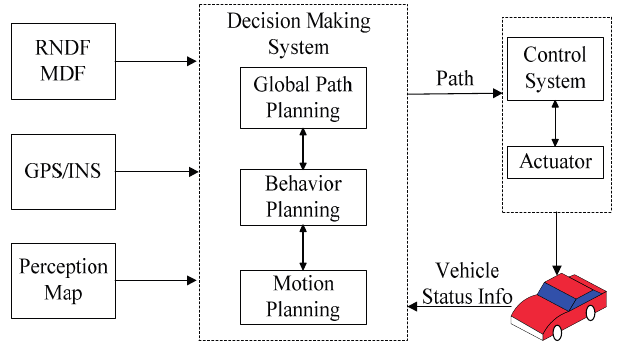
Figure 2. The software architecture of decision-making